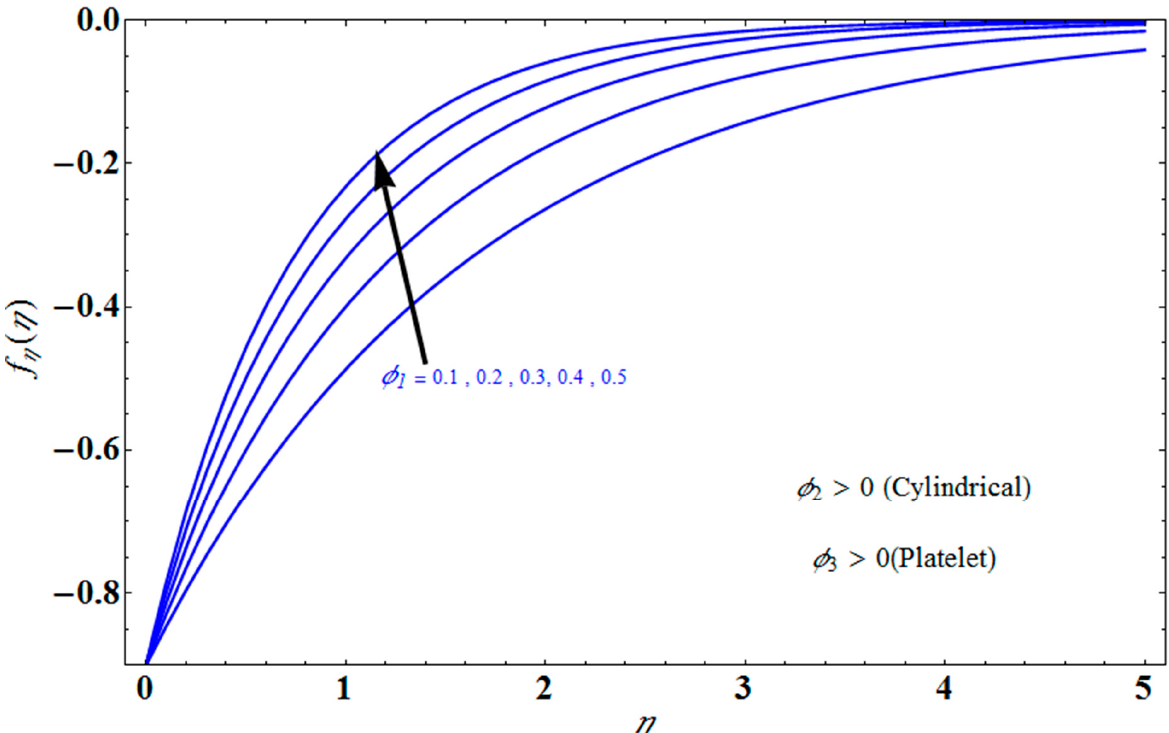
( ) η η f on for different values of η